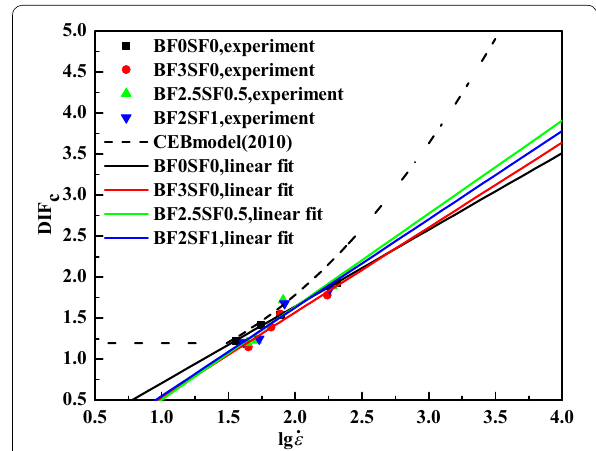
Fig. 8 Dynamic increase factor vs. strain rate.